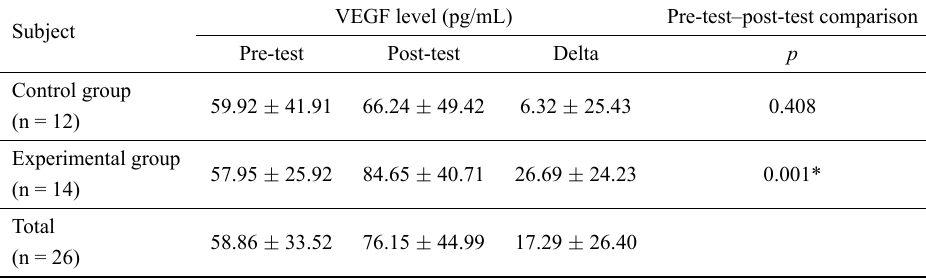
Table 4. Comparison of VEGF values.